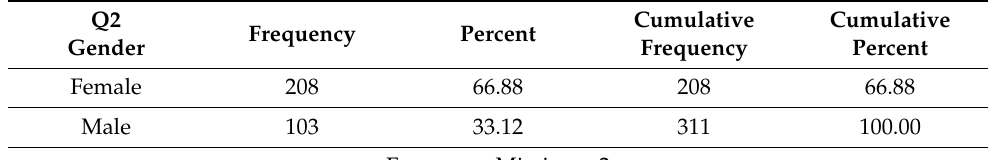
Table 1. Frequency for gender.